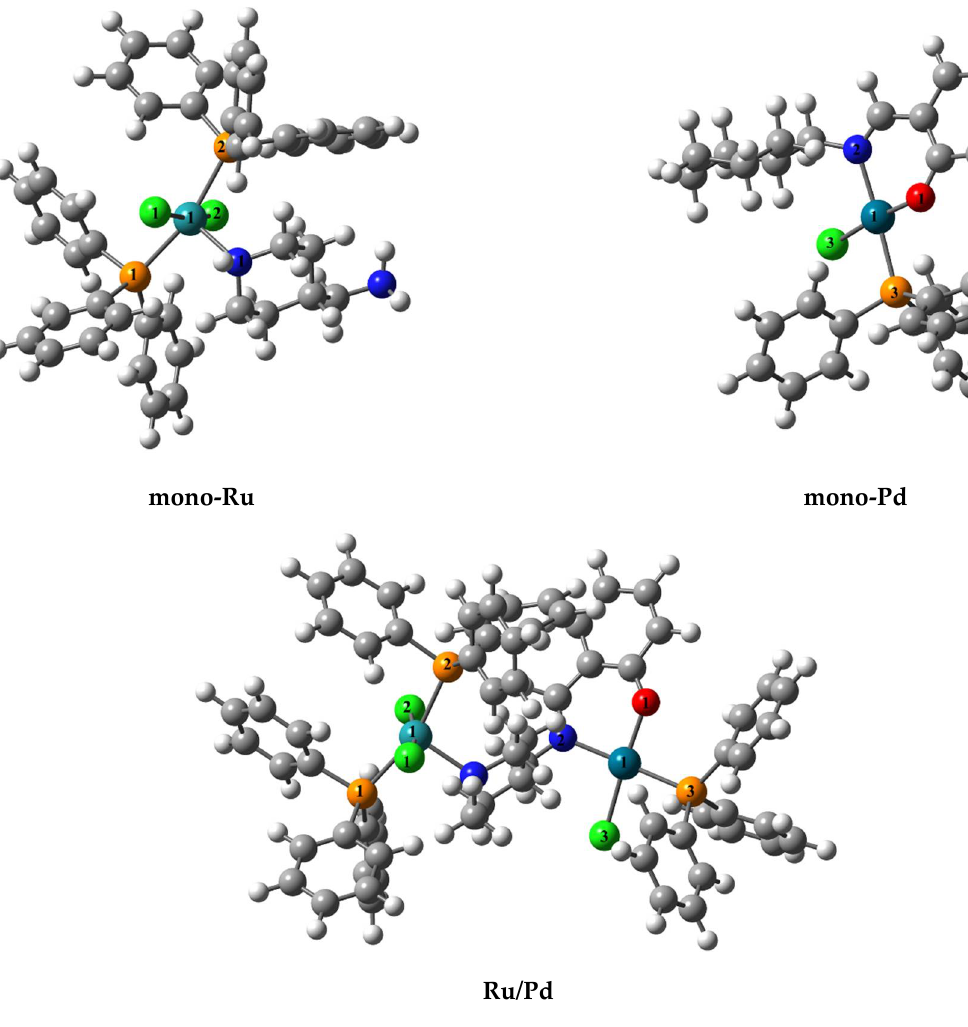
Figure 1. Views of the optimized structures of mono-Pd, mono-Ru, and Ru/Pd. Table 1. Theoretical bond distances (Å) and bond angles (°) for mono-Ru, mono-Pd, and Ru/Pd. Geometric Parameters mono-Ru Ru/Pd